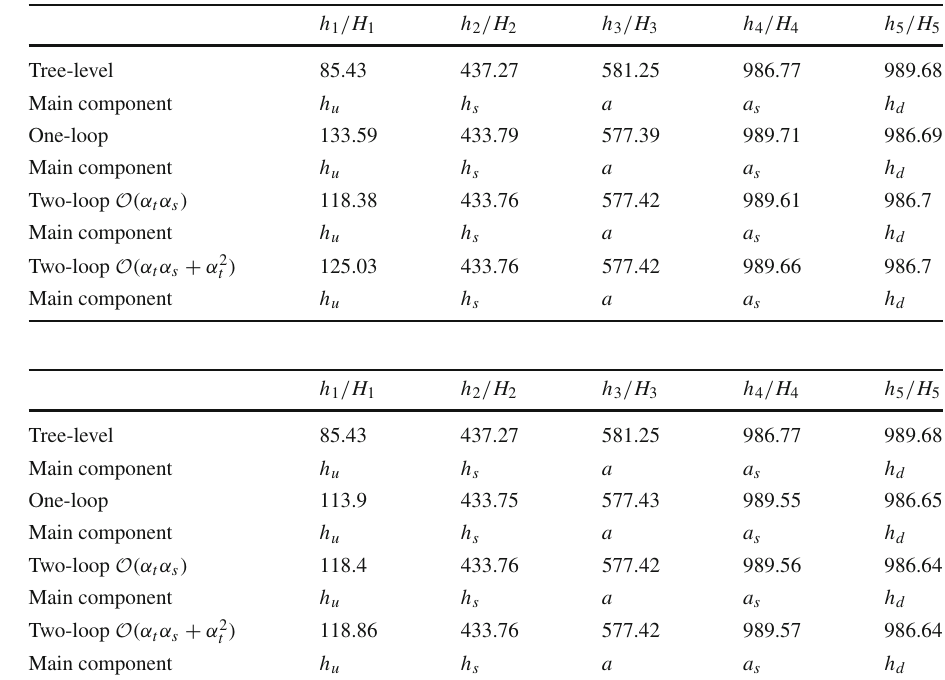
Table 4 P2: mass values in GeV and main components of the neutral Higgs bosons at tree level, one-loop level, two-loop α ) level and at two-loop O (α t s α + α 2 ) level obtained by O (α t s t using OS renormalization in the top/stop sector